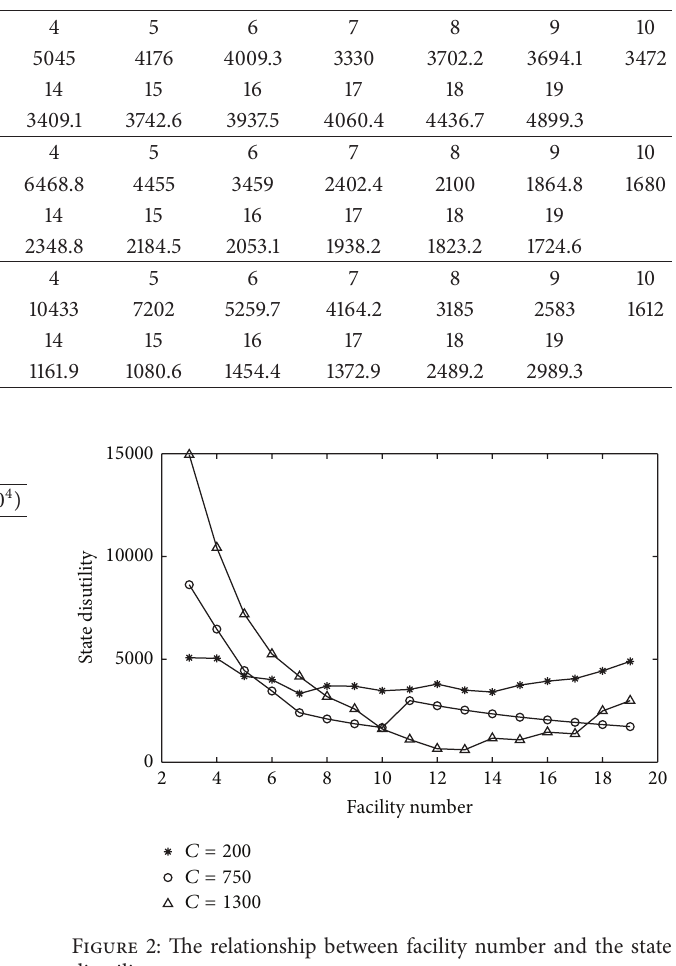
Table 1: The state disutility under different scenarios.